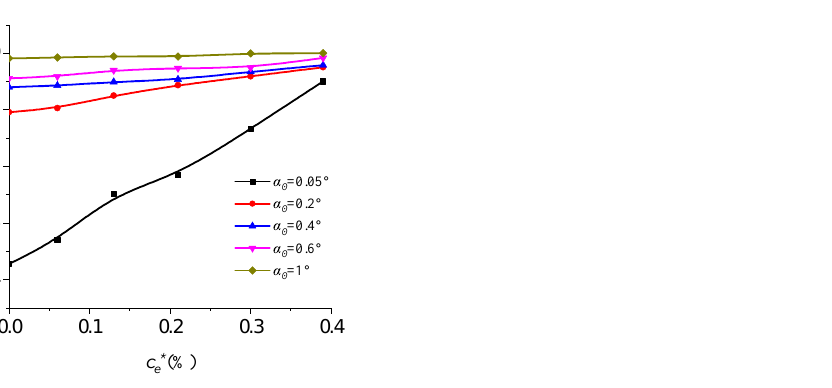
Figure 13. The static pressure and velocity magnitude distributions near the narrow gap between two guide vane blades during one vibration cycle: ( a ) static pressure; ( b ) velocity magnitude.